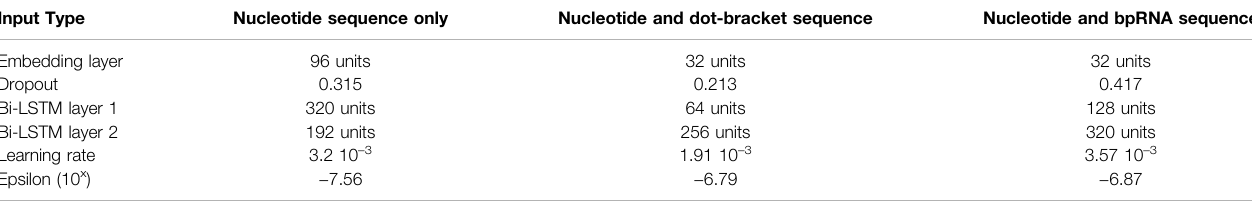
TABLE 1 | Tuned parameters for each DeepMirCut model and type of input.